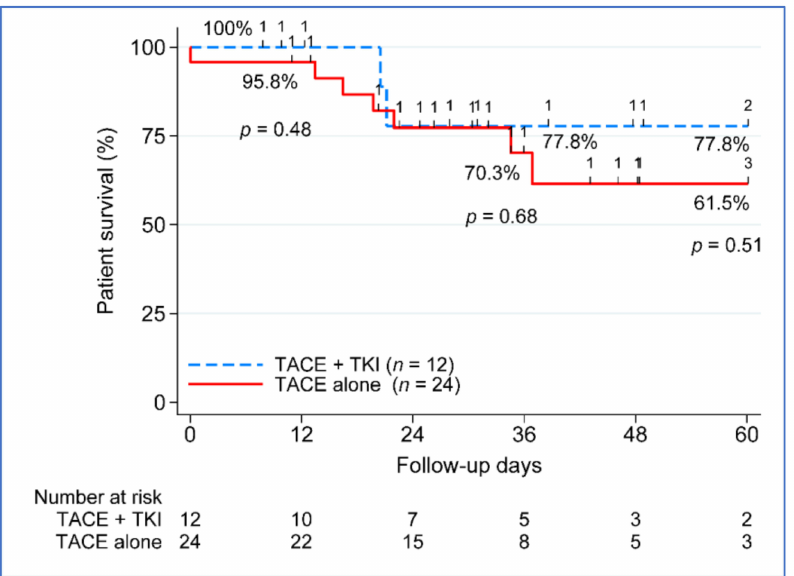
Figure 4. Five-year patient survival post-transplant. TACE, transarterial chemoembolization; TKI, tyrosine kinase inhibitor; and n ,